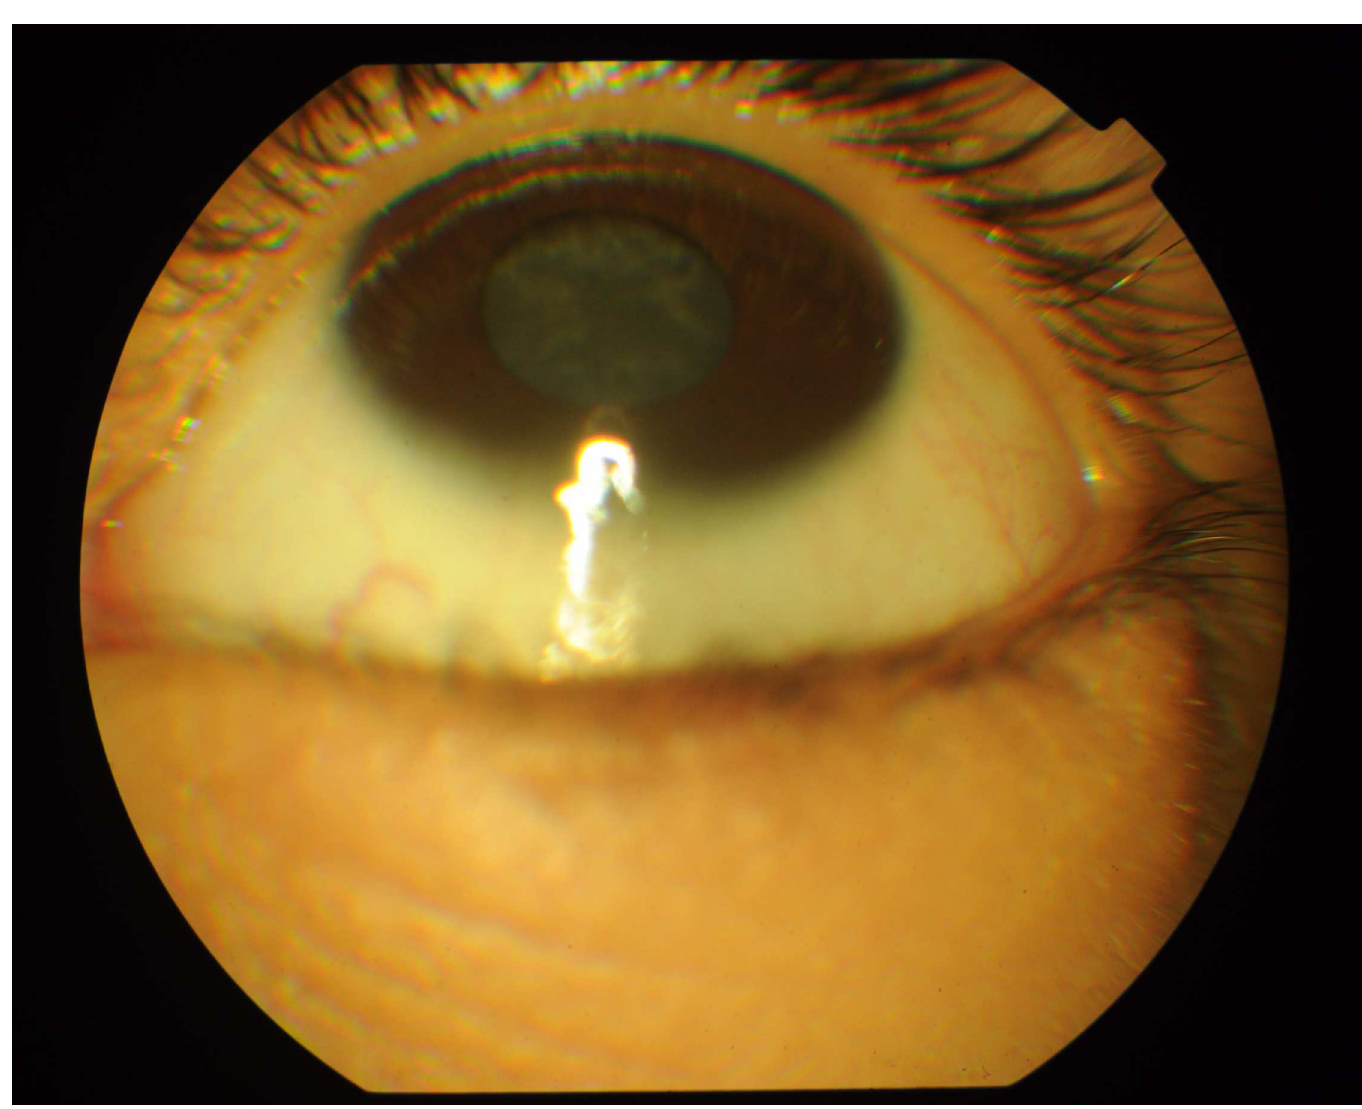
Fig 2. Slit-lamp photograph of affected individual 9 of PKCC214. This photograph depicts a nuclear cataract that developedduring